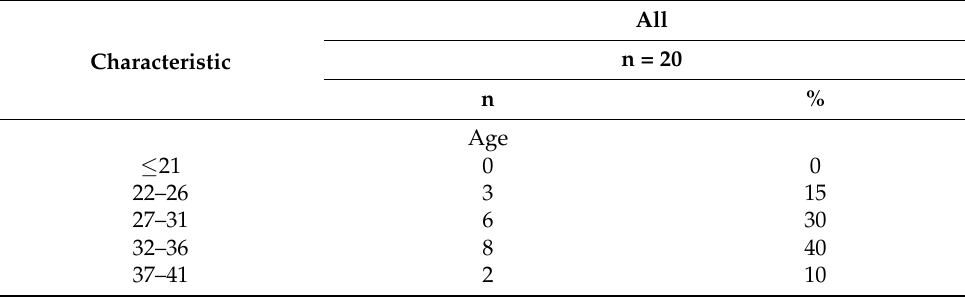
Table 1. Participant demographic